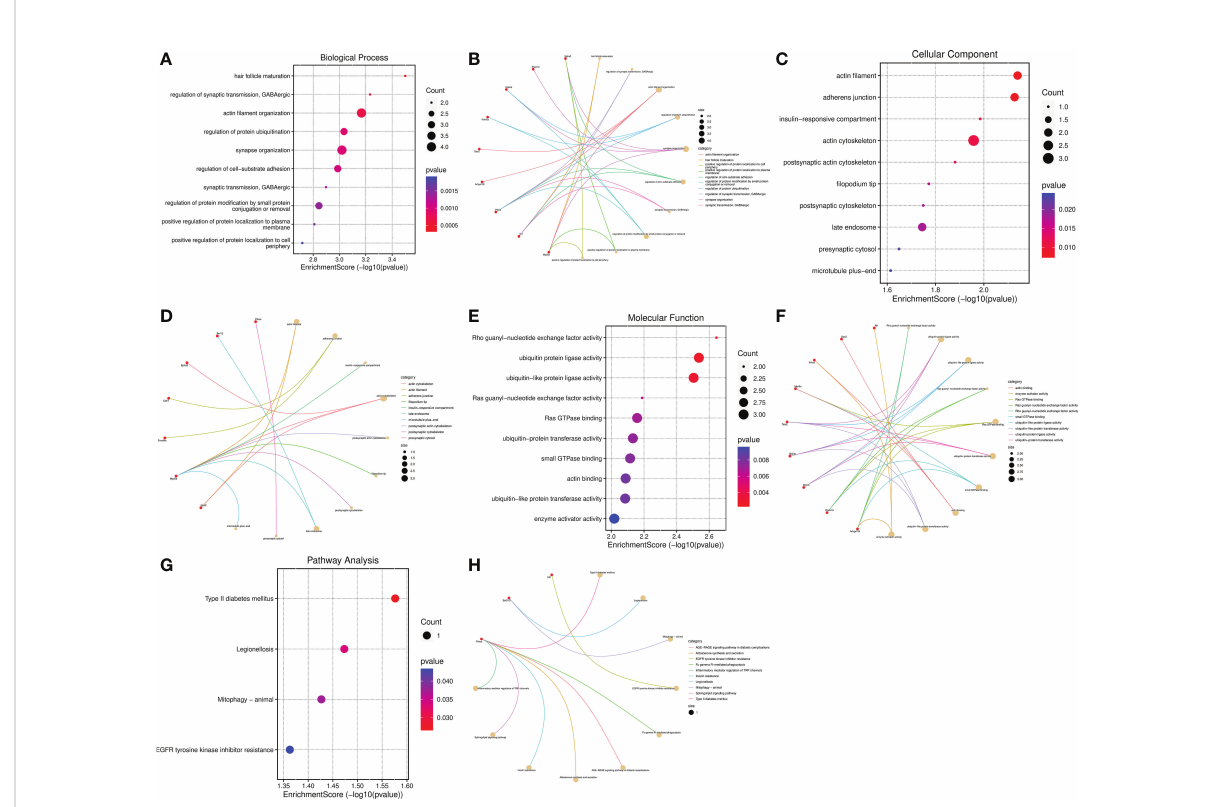
FIGURE 6 Functional and pathway enrichment analysis of the host genes of DECs. (A – F) Bubble diagram and cnetplot showing the host genes of DECs enriched in the different GO categories, including BP, CC, and MF. (G, H) KEGG pathway enrichment analysis of the host genes of